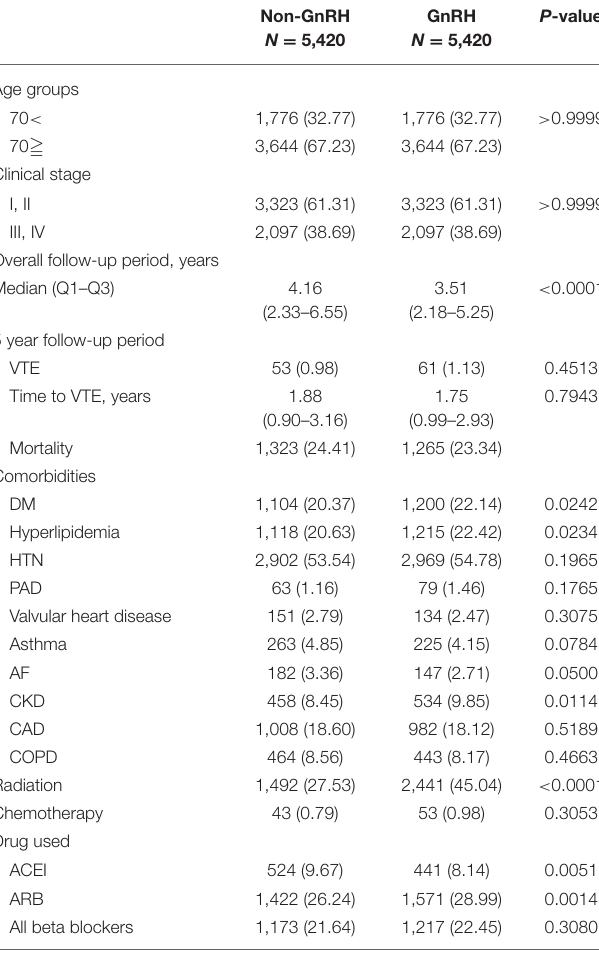
populations that are at a high risk. Through the subgroup analysis among patients receiving GnRH therapy, interestingly, those younger than 70 years old or at an earlier cancer stage (Stage